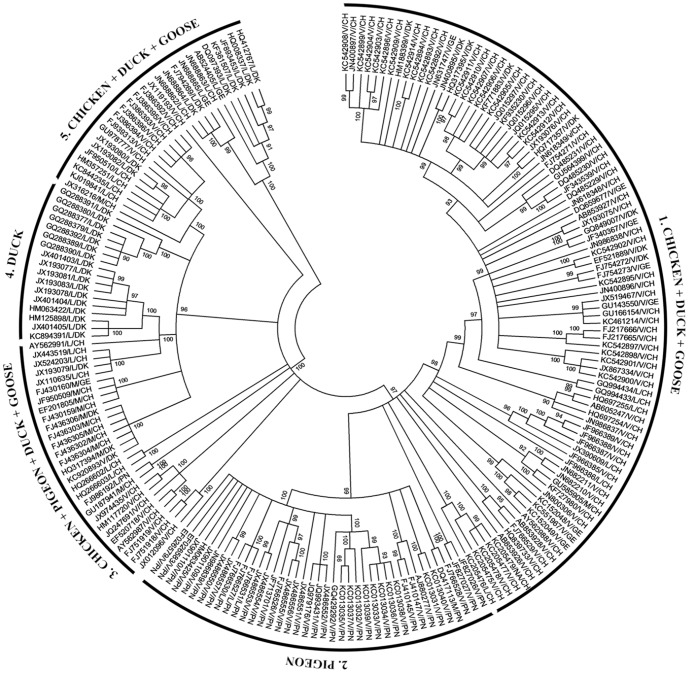
Phylogenetic tree illustrating relationship among the 201 Newcastle disease virus (NDV) strain (labelled as accession no/pathogenic/species) following the neighbour-joining method using MEGA6 software.Parameters include: pairwise deletion, 1000 replicates for bootstrap analysis and Jukes-Cantor substitution model, the rate variation among sites was modelled with a gamma distribution (shape parameter  =  5). L, M and V stands for lentogenic, mesogenic and velogenic strains. CH, PN, DK and GE stands for the chicken, pigeon, duck and goose, respectively.